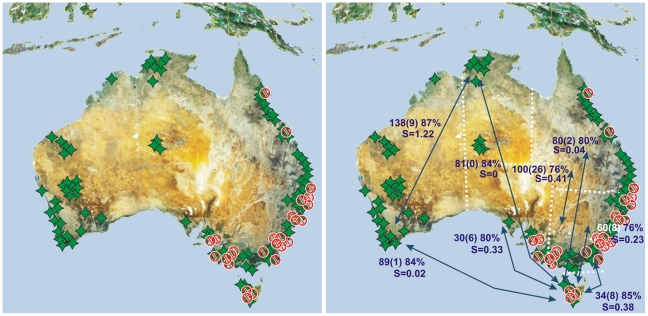
Geographical origin of samples and regional comparisons.(A) Geographical origin of sequenced Australian individuals (green stars), red  =  specimens in paraphyletic clusters. (B) Molecular biodiversity estimation employed for regional comparison. Arrows  =  states compared; Numbers  =  number of clusters using 3% threshold for all samples from the two areas compared (N of clusters shared between two areas) % of clusters that perfectly agree with existing taxonomy; S = Sørensen Index.